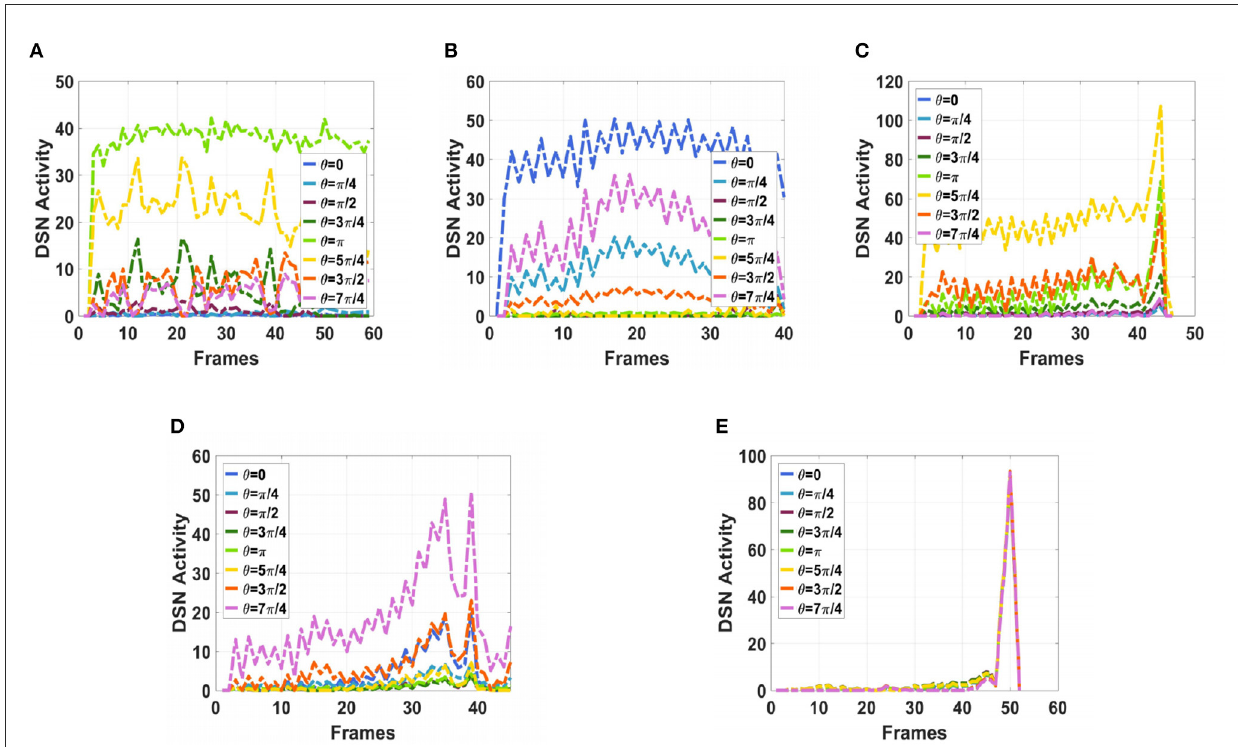
FIGURE10 The output activity of the directionally selective fractional-order LGMD collision sensing visual neural network. (A) The ball moves to the left. (B) The ball moves to the right. (C) The ball moves downwards to the left. (D) The ball moves downwards to the right. (E) The ball is looming moving toward the center.